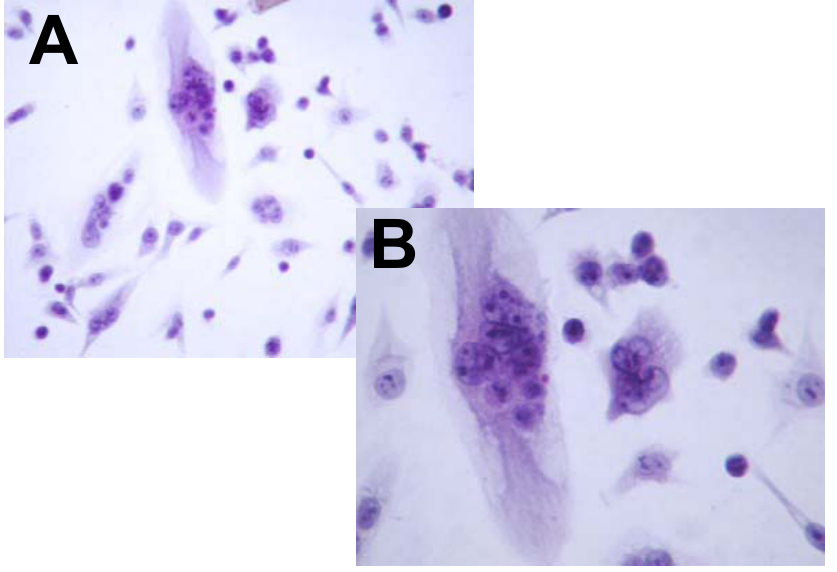
Fig. 1 Cellular modification induced by adenovirus on TV cell. (HE staining: (A) HE × 200, (B) HE ×